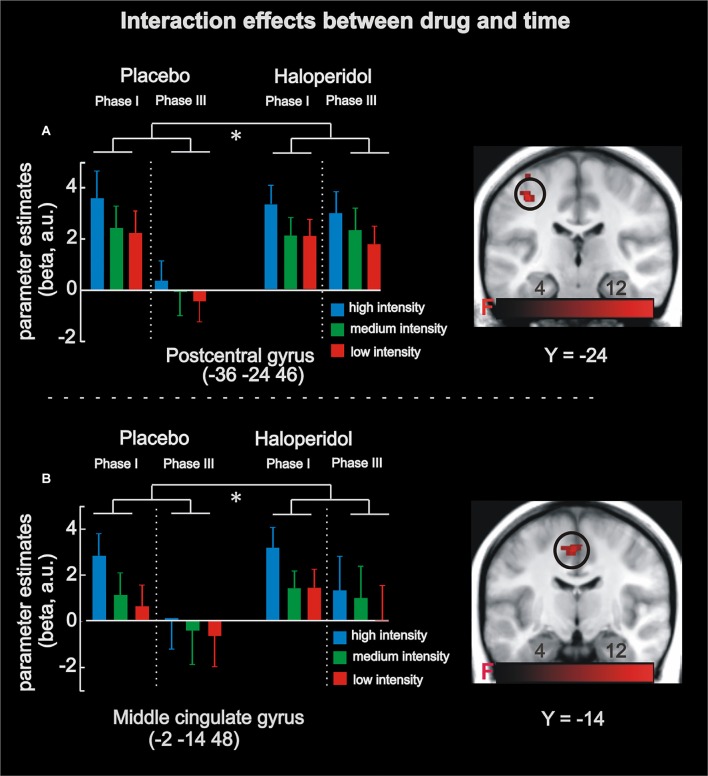
fMRI results in the absolute task. Analyses revealed a significant interaction between stimulation magnitude, drug and time in left postcentral gyrus (A) and left midcingulate cortex (B). Under placebo in phase I, activity increased as a function of stimulation magnitude (absolute coding), and this effect was absent in phase III (i.e., habituation). Under haloperidol, however, there was no significant habituation from phase I to phase III. The significant interaction effects are highlighted by the asterisk. Maps of activations are superimposed on a T1 group template. Error-bars denote one standard error of the mean.